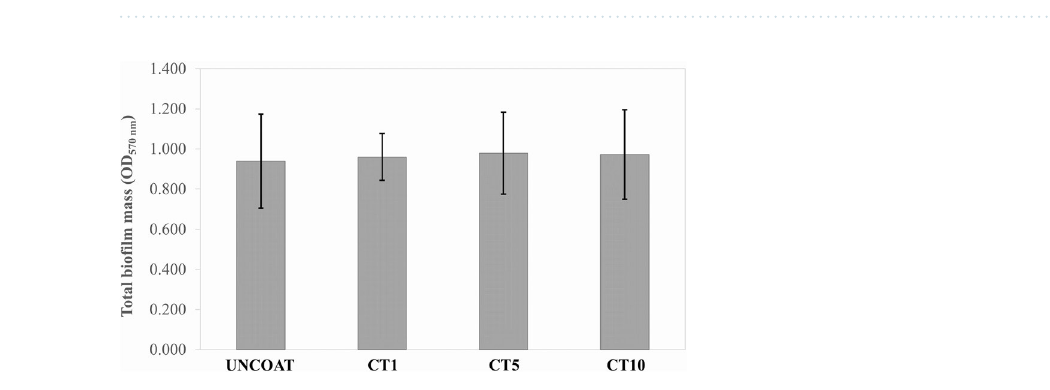
Figure 4. Surface roughness (Ra, nm) of the uncoated NiTi alloy sample and the GO/AgNPs coated NiTi alloy samples with different coating times. Asterisk (*) represents a significant difference ( p < 0.05) by Welch’s ANOVA and Game-Howell multiple comparison tests.